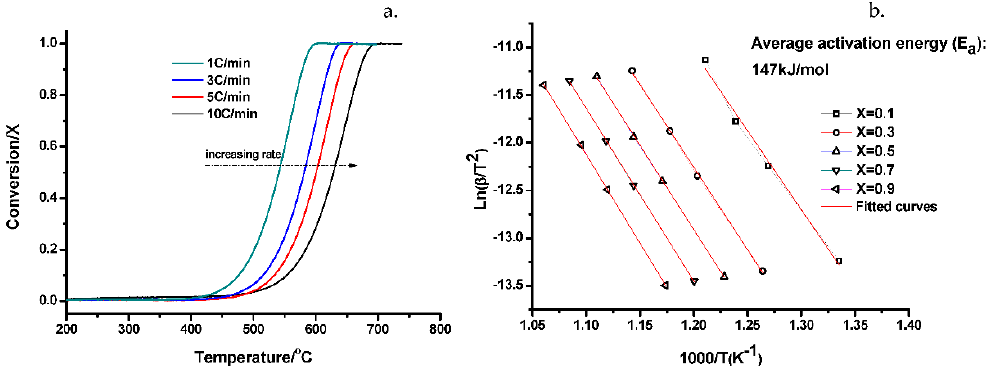
Figure 7. ( a ) TGA oxidation curves for flame soot FS100 obtained at different heating rates; ( b ) Isoconversion plots at various conversion degrees for flame soot FS100. (Non-isothermal oxidation at different heating rates: 1 °C/min, 3 °C/min, 5 °C/min and 10 °C/min.).